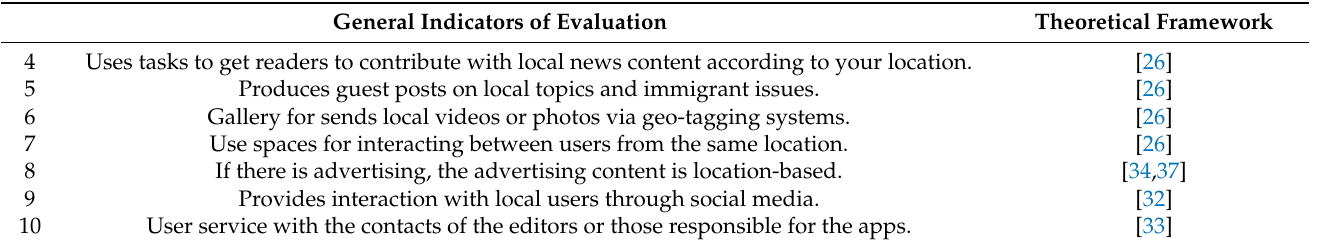
Table 2. What tools are provided for the participation of local citizens to contribute to produce local news content? General Indicators of Evaluation Theoretical Framework